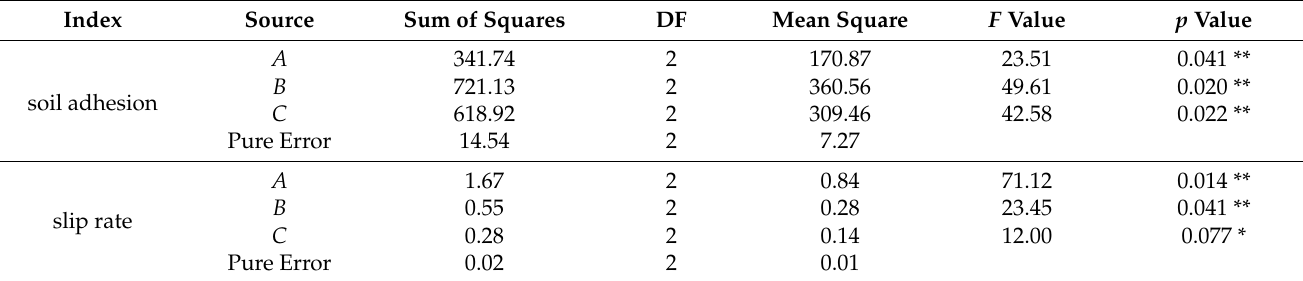
Table 3. Variance